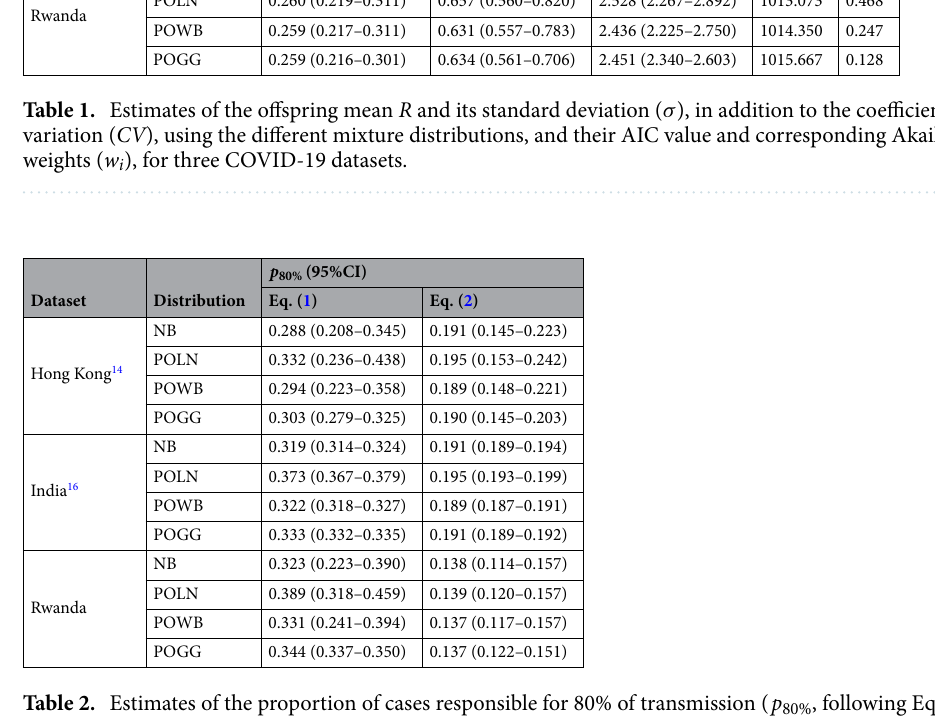
Table 2. Estimates of the proportion of cases responsible for 80% of transmission ( p 80% , following Eqs. (1) and (2) using the different mixture distributions, for three COVID-19 datasets. Estimates based on the negative binomial distribution correspond to those reported in the literature for the two published datasets.